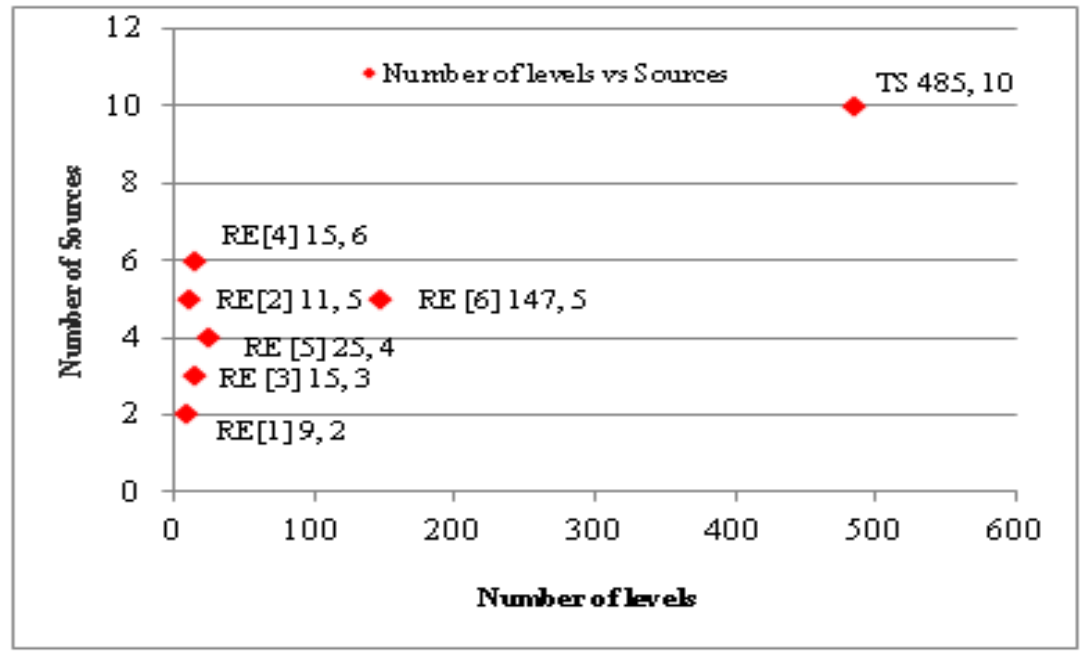
Figure 6. Sketch between the number of voltage levels and sources.